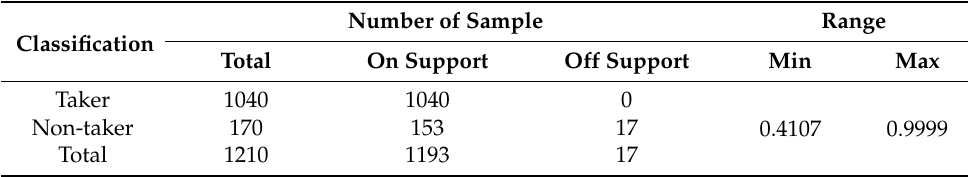
Table 4. Range of common supports between dietary supplements taker and non-taker. Classification